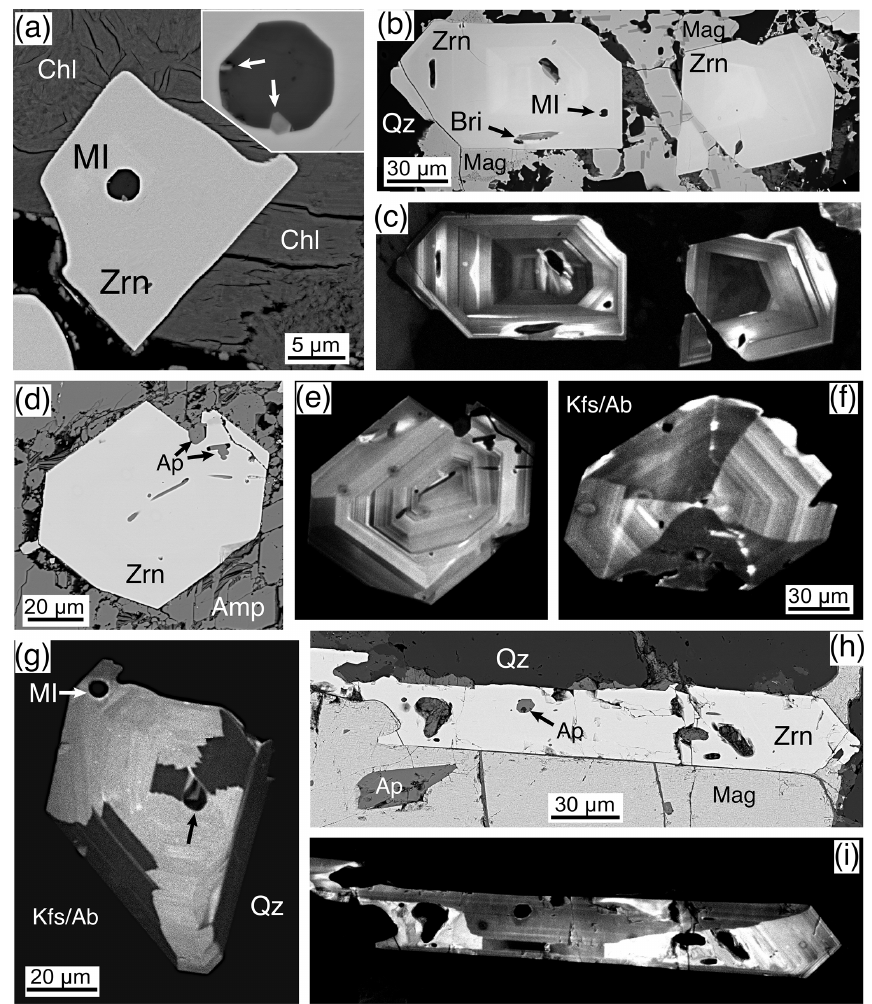
Figure 2. Magmatic zircons, BSE images except where noted. (a) A 20µm euhedral zircon (Zrn) enclosed by chlorite (Chl) with a 2.5µm silicate-melt inclusion (MI). The inclusion is enlarged in the upper right; the lower arrow indicates a euhedral-zoned apatite, and the upper arrow points to a TiO 2 phase. Rum, Western Granite, sample RUM. (b) Two ∼ 90µm euhedral zircons (Zrn) with silicate-melt (MI), and britholite (Bri) inclusions, enclosed by quartz (Qz) with magnetite (Mag). Mull, Toll Doire Granophyre, sample 44858. (c) CL image of (b) showing sharply defined magmatic oscillatory zoning. (d) An 80µm euhedral zircon (Zrn) with apatite (Ap) inclusions enclosed by riebeckite amphibole (Amp) somewhat disaggregated from sample preparation. Skye, Western Red Hills Centre, Maol na Gainmich Granite, sample 14709. (e) CL image of (d) showing fine-scale oscillatory zoning; the left border shows sector zoning. (f) CL image of a 130µm euhedral zircon enclosed by K-feldspar and albite (Kfs/Ab) showing fine-scale oscillatory zoning with well-developed sector zoning. Skye, Eastern Red Hills Centre, Creag Strollamus Granite, sample H1226. (g) A CL image of an 80µm zircon (Zrn) surrounded by quartz (Qz) and K- feldspar and albite (Kfs/Ab) with well-developed sector zoning. The crystal contains a silicate-melt inclusion (MI) in the upper left, but the similarly shaped dark spot (black arrow) is a non-CL part of the crystal. Skye, Eastern Red Hills Centre, Glas Bheinn Mhor Granite, sample GBME. (h) An acicular 300µm (a portion on the left not shown) euhedral zircon (Zrn) on magnetite and intergrown (left portion) with quartz (Qz). Apatite inclusions (Ap) in both the zircon and magnetite. Skye, Eastern Red Hills Centre, Glas Bheinn Mhor Granite, sample GBME. (i) A CL image of (h) showing oscillatory and sector